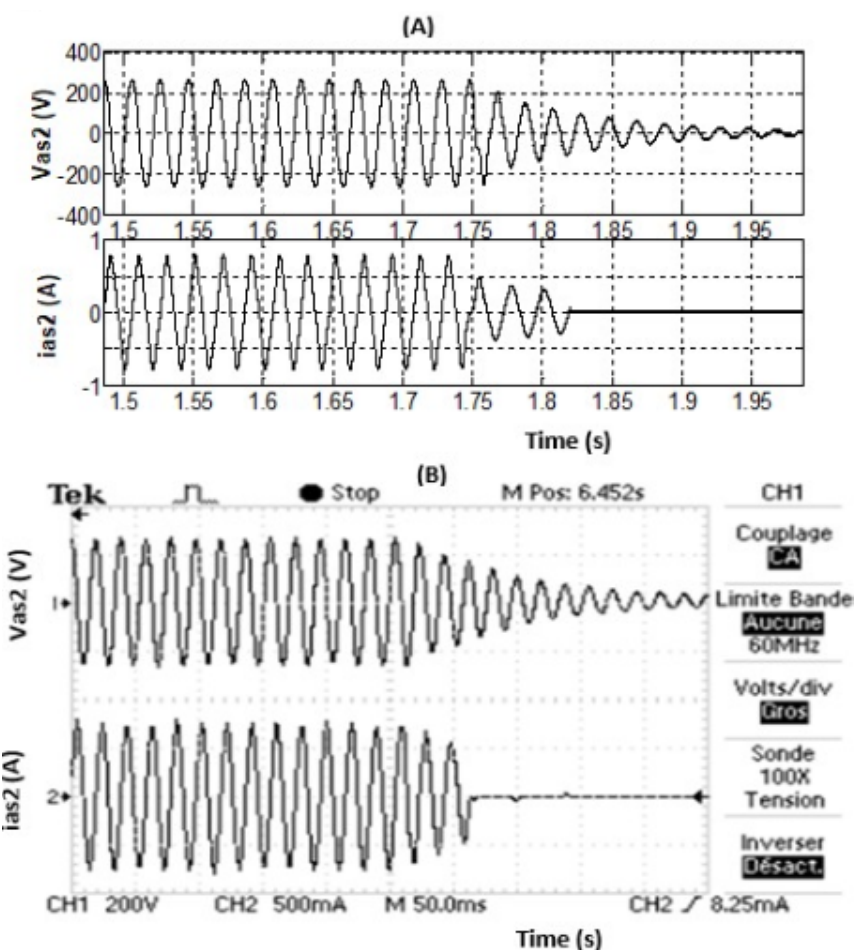
Figure 11. Defuse voltage and stator current for C = 7.8 µF: ( A ) theoretical and ( B ) experimental.